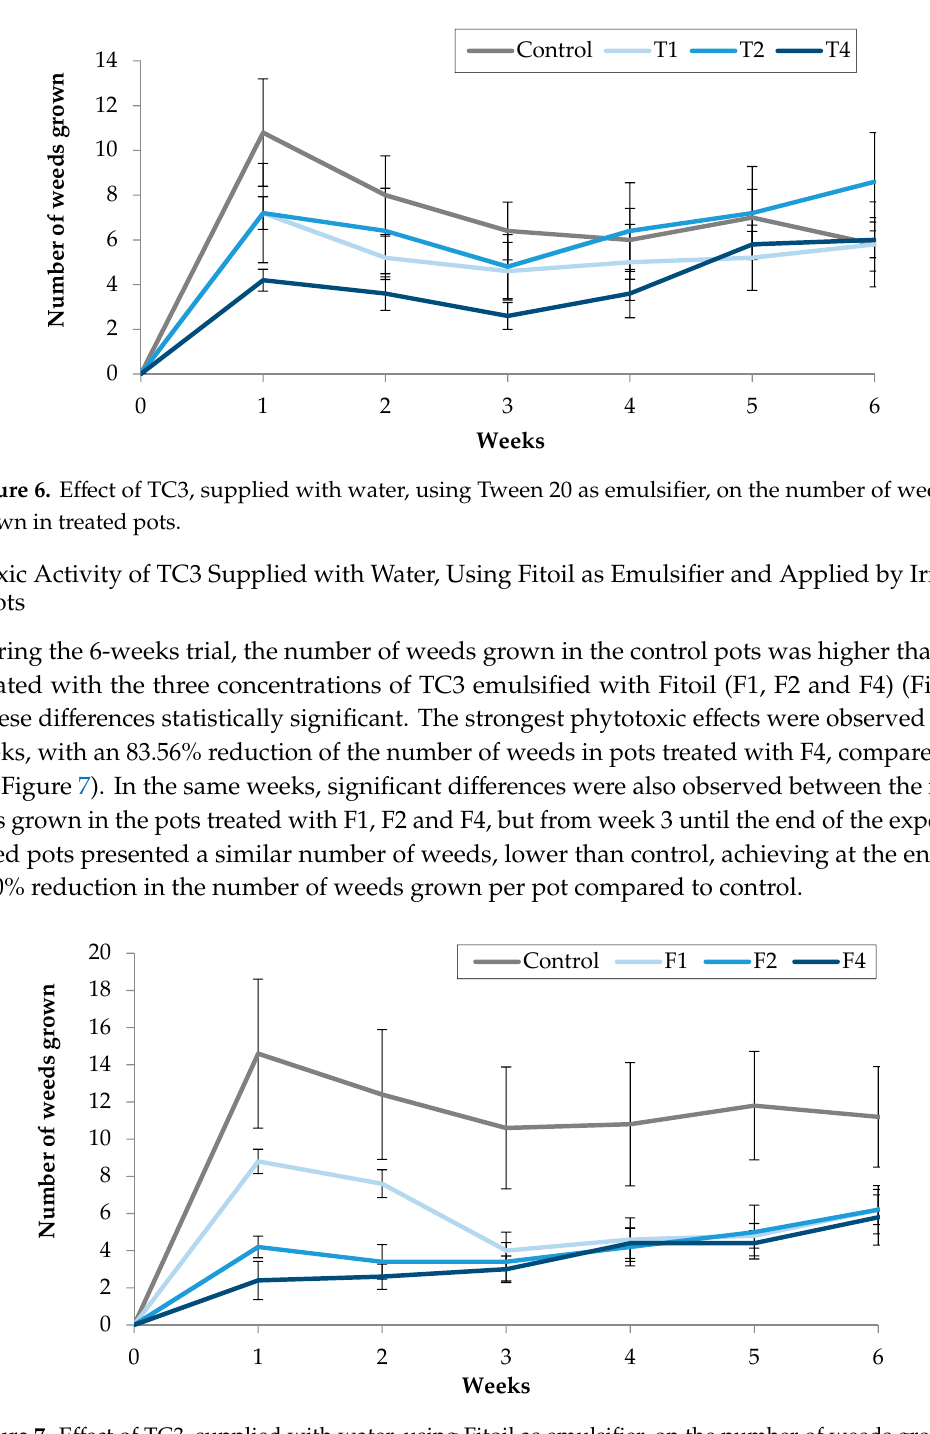
10 of 31 Figure 5. Effect of TC3, injected into the soil, on the number of weeds grown in treated pots. Phytotoxic Activity of TC3 Supplied with Water, Using Tween 20 as Emulsifier and Applied by Irrigation to the Pots The first week after treatments application, statistically significant differences were observed between the number of weeds grown in the control pots and those counted in the treated pots, with